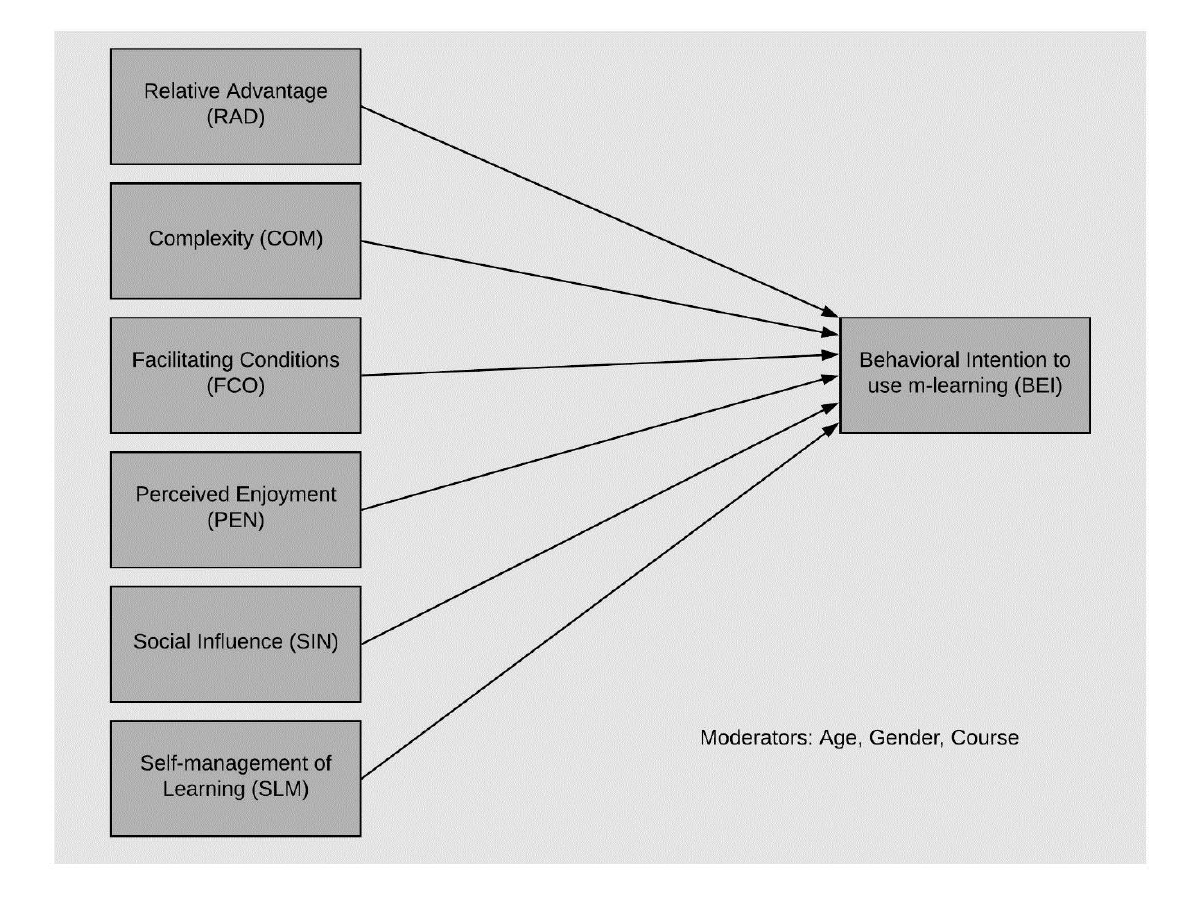
Figure 1: The research